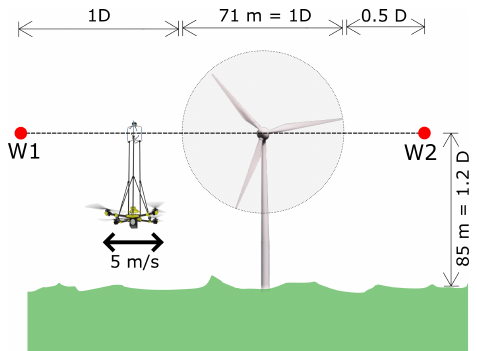
Figure 18. Flight path of the OPTOkopter behind the wind turbine (view from the front). The drone oscillates with 5ms − 1 between waypoints W1 and